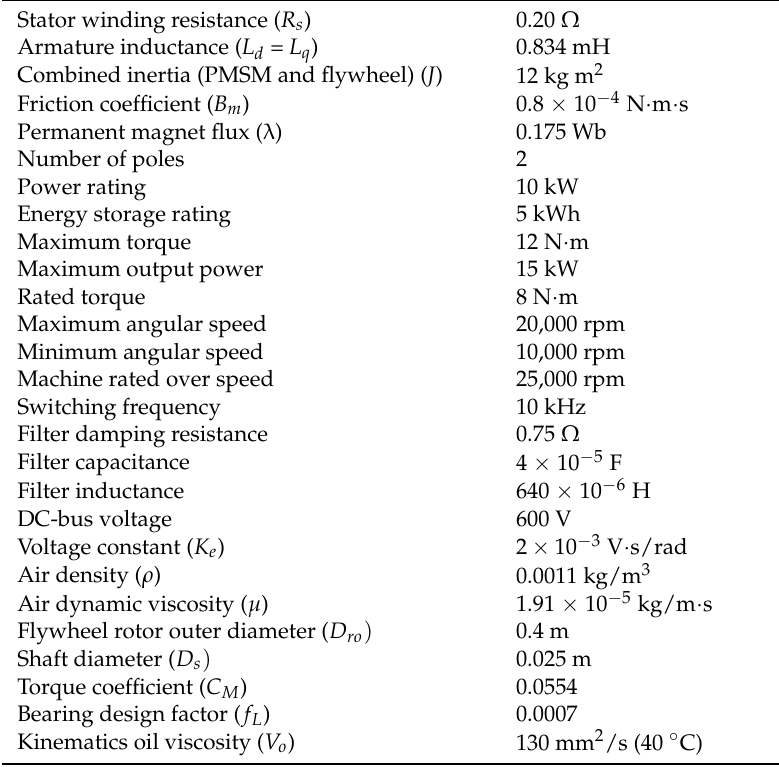
Table 5. Parameters and coefficients of a combined surface-mounted permanent magnet synchronous motor (PMSM) 1 and flywheel energy storage systems